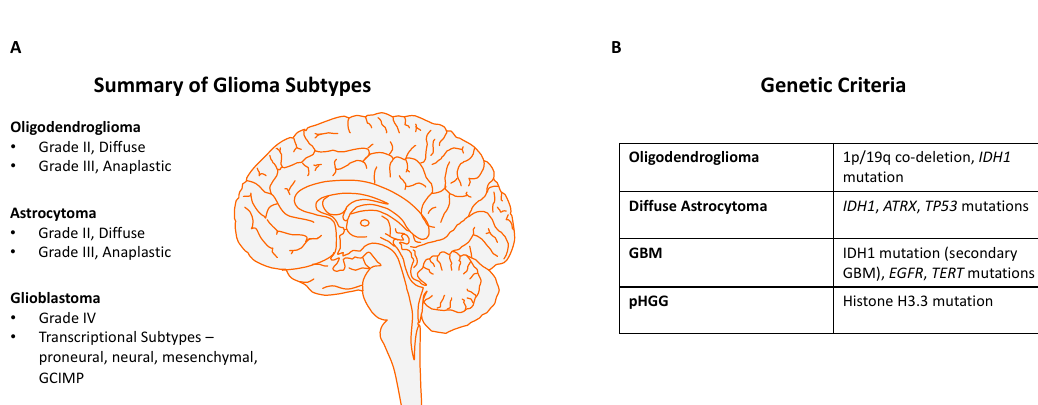
Figure 1. A ) Summary of glioma subtypes, including oligodendroglioma, astrocytoma and glioblastoma (GBM). The transcriptional subtypes of GBM are based on large-scale transcriptomics of human GBMs [25]. ( B ) The genetic features of these glioma subtypes, with the typical mutations seen in each category. The diagnosis of glioma is currently based on integration of classical histopathology with defining mutations (World Health Organisation (WHO) criteria). ‘pHGG’ refers to pediatric high-grade glioma, which has a different spectrum of mutations compared with adult GBMs. Illustration was prepared using the Motifolio drawing toolkit.